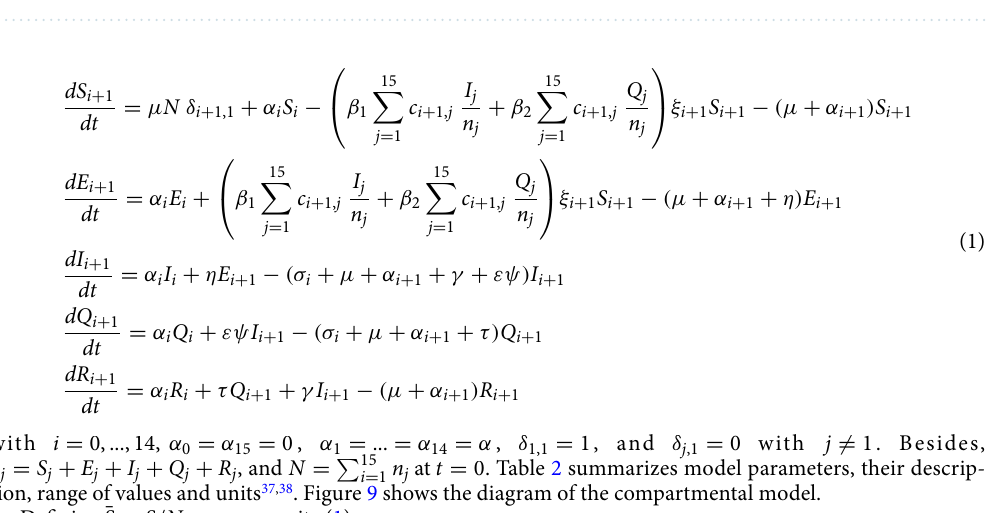
Figure 8. The geographic location of the municipalities enlisted in the study. The heatmap shows the interpolation result of the total number of cases per 100 thousand inhabitants in those cities recorded on July 28th. Cool colors mean less infected individuals while warm colors more infected individuals, and the scale goes from 153.6 (blue) to 4617.7 (red) cases per 100 thousand inhabitants. The cities were geocoded using the software Qgis (v3.10), and the interpolation was performed using the software’s tool for Inverse Distance Weighted Interpolation (https:// www. qgis. org/ en/